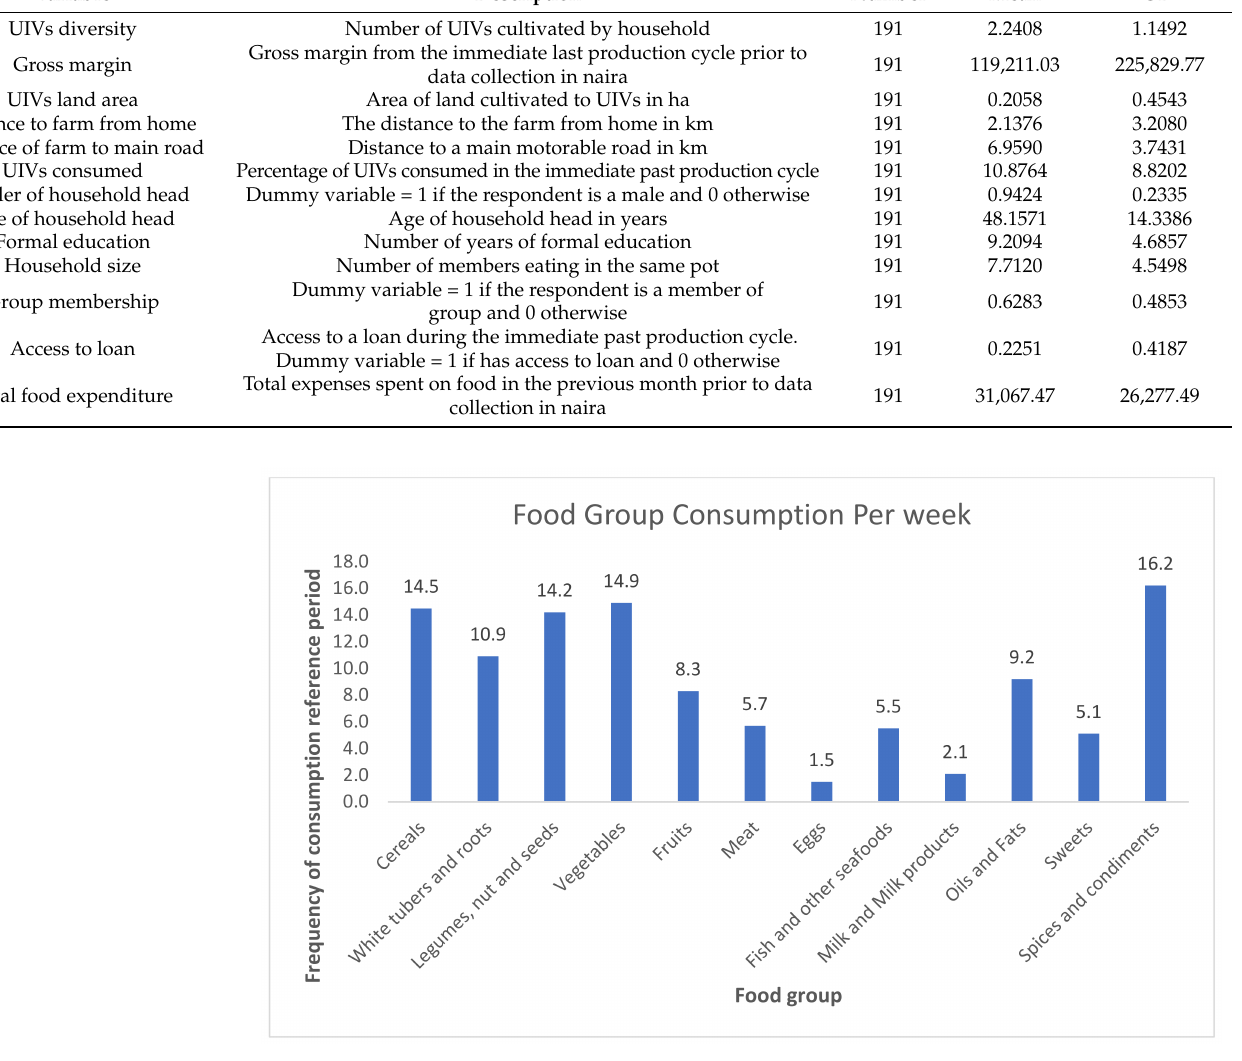
Figure 2. Food group consumption per week. Table 3. Household dietary diversity score